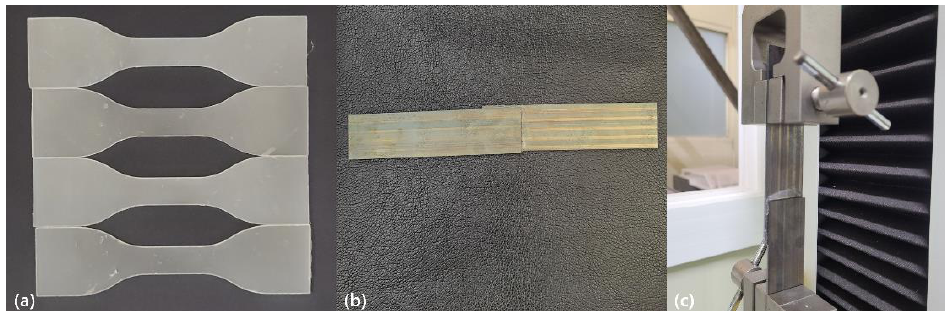
Figure 3. PHA–CNFs composite specimens for ( a ) Tensile test; ( b , c ) Lap shear test.